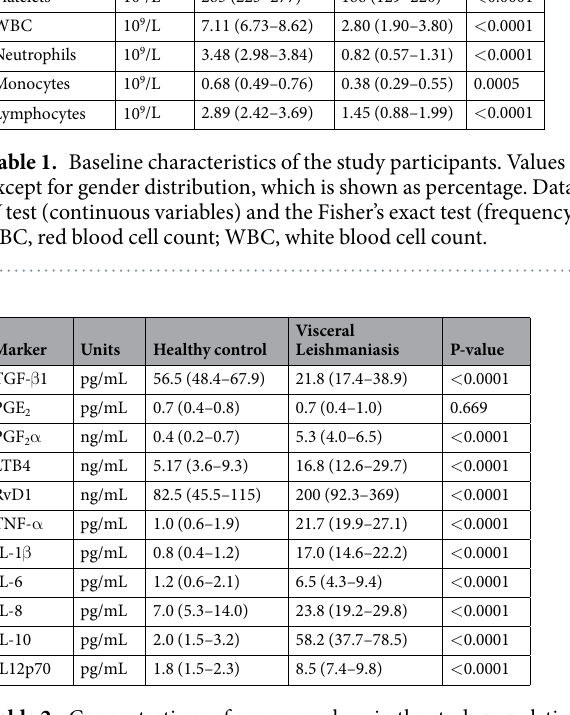
Table 2. Concentrations of serum markers in the study population. Values represent median and interquartile ranges. Data were analyzed using the Mann-Whitney U test (continuous